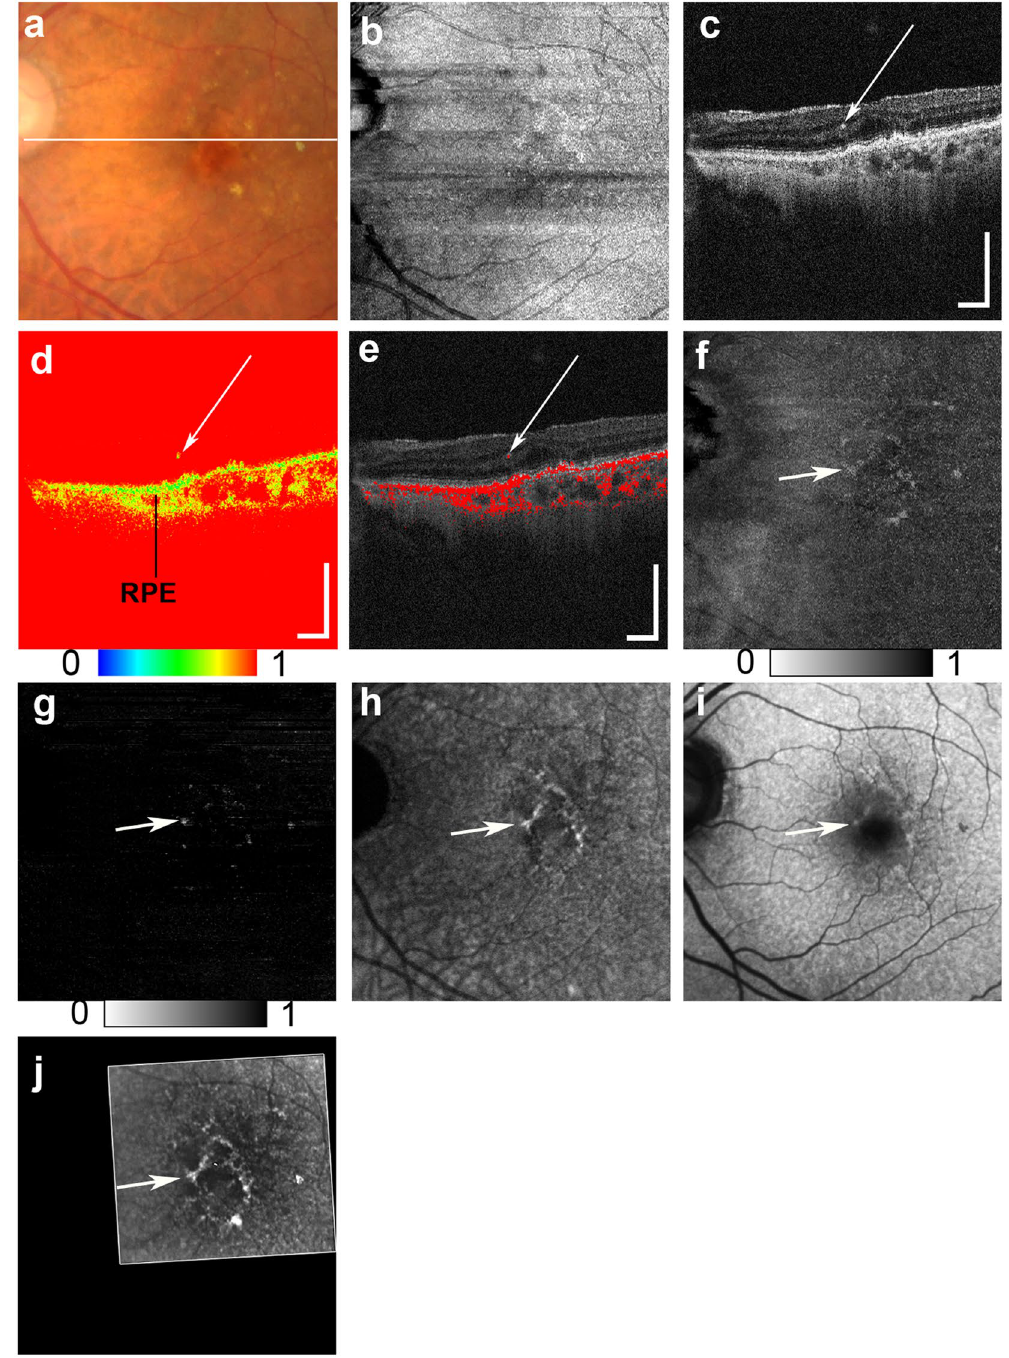
Figure 1. Multimodal imaging of early to intermediate age-related macular degeneration (AMD) from the left eye of an 81-year-old female. The white line in the color fundus photograph ( a ) indicates the scan line of the polarization sensitive optical coherence tomography (PS-OCT) B-scan images ( c,d,e ). An en face projection of the standard OCT image ( b ). A standard OCT B-scan image ( c ) showing hyperreflective foci (HRF; white arrow). A pseudocolor image of the corresponding degree of polarization uniformity (DOPU) B-scan image ( d ) and composite DOPU B-scan OCT images (e) showing depolarization at the HRF (white arrows). The scale bars represent 500 μ m × 500 μ m. An en face projection image of the minimum DOPU along the whole depth ( f ) and an en face projection of the minimum DOPU anterior to the retinal pigment epithelium ( g ), which showed depolarization at corresponding locations of HRF (white arrows). The autofluorescence (AF) images at 787 nm (NIR-AF) ( h ) and 488 nm (SW-AF) ( i ) show hyper-AF at corresponding locations of HRF (white arrows). A depolarized light image using the polarization sensitive scanning laser ophthalmoscope (PS-SLO) ( j ) shows depolarization at corresponding locations of HRF (white